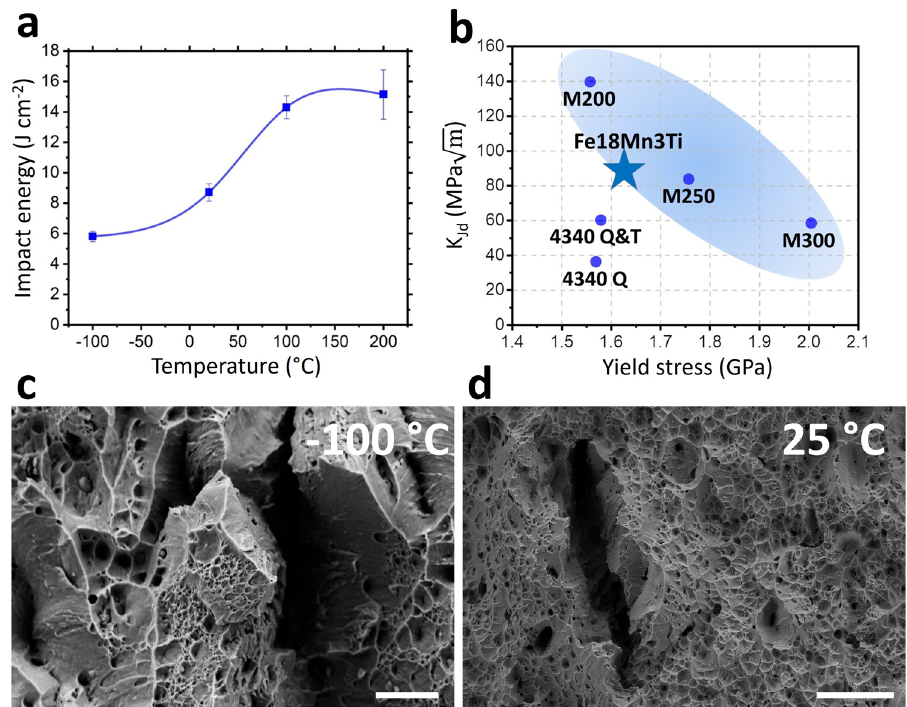
Fig. 5 Impact tougness. a Impact energy (subsize Charpy V-notch specimens) at different temperatures of the Fe18Mn3Ti alloy cold rolled and annealed during 1 h at 450 °C. Datapoints represent the average and standard deviation for 3 measurements. b dynamic impact toughness of the Fe18Mn3Ti alloy as compared to other ultra-high strenght steel grades. c , d Center regions of the fracture surfaces of the material after impact testing at − 100 °C ( c ) and 25 °C ( d ). c Scale bar: 10 μ m. d Scale bar: 40 μ